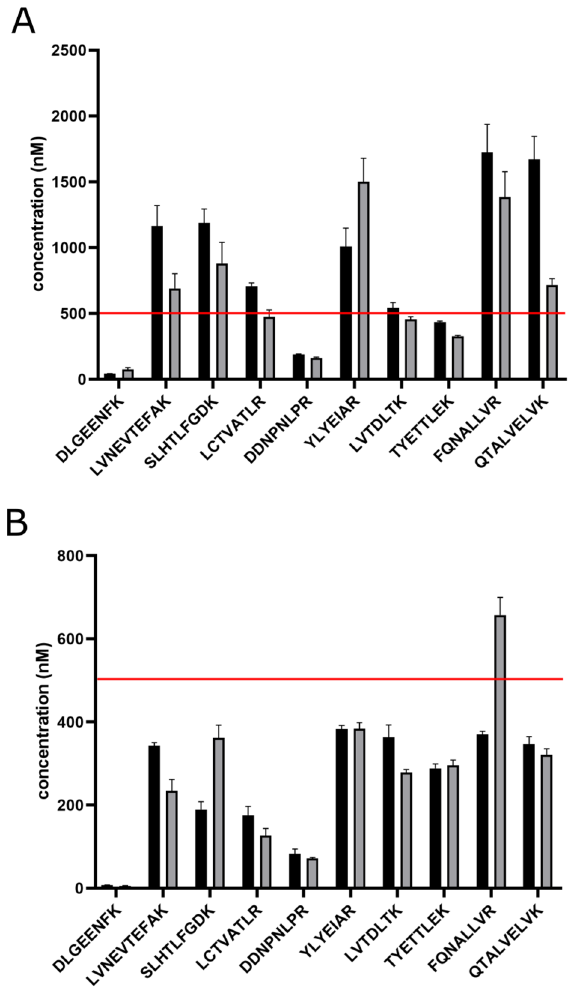
Figure 2. The quantitative performance depends on the reconstitution solvent for SIL-TCT (black) and SIL- ExC5 (grey) peptides. The reconstitution solvent was water with 5% ACN ( A ) and AmBic/SDC buffer with 5% ACN ( B ). The reference HSA protein concentration marked with the red line at 500 nM (determined by BCG assay and protein assay using